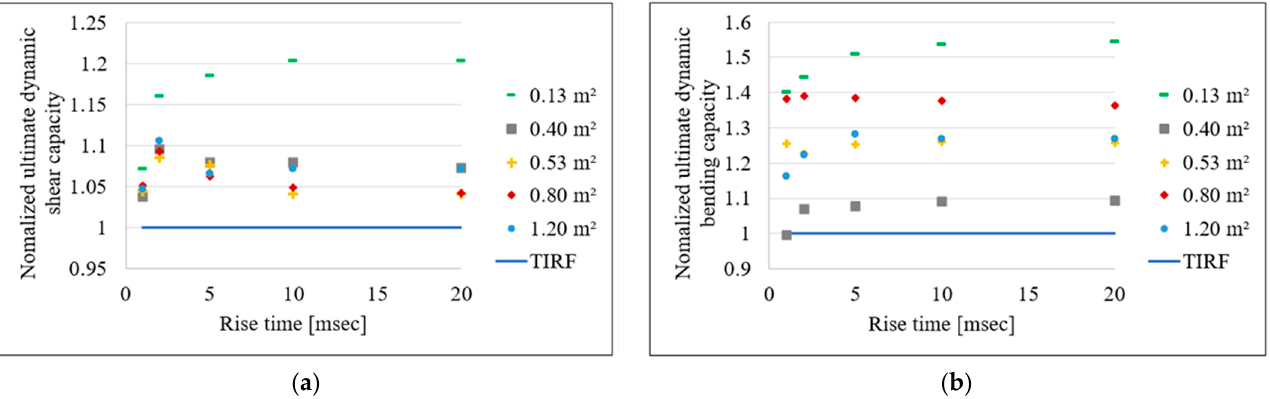
Figure 23. Normalized ultimate dynamic capacities using TIRF and DIR: ( a ) Shear capacity ( b ) Bend- ing